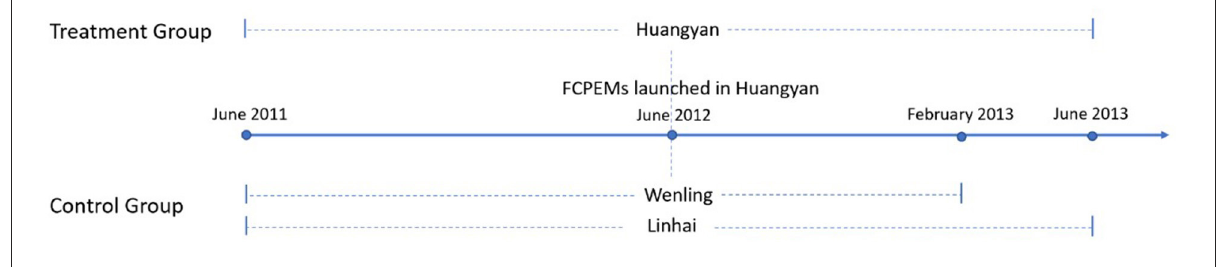
FIGURE1 Study timeline. Wenling implemented the FCPEMs in February 2013. Linhai launched its respective policy in October 2013, which is beyond the study period.